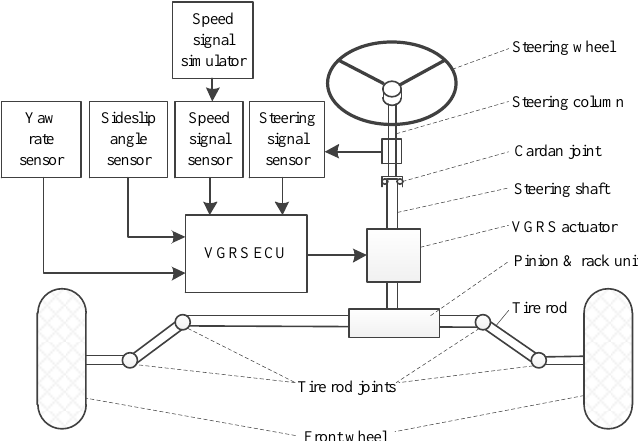
Figure 2. Construction of AFS system with the VGRS Figure 2 . Construction of AFS system with the VGRS actuator. Figure 2 . Construction of AFS system with the VGRS actuator.